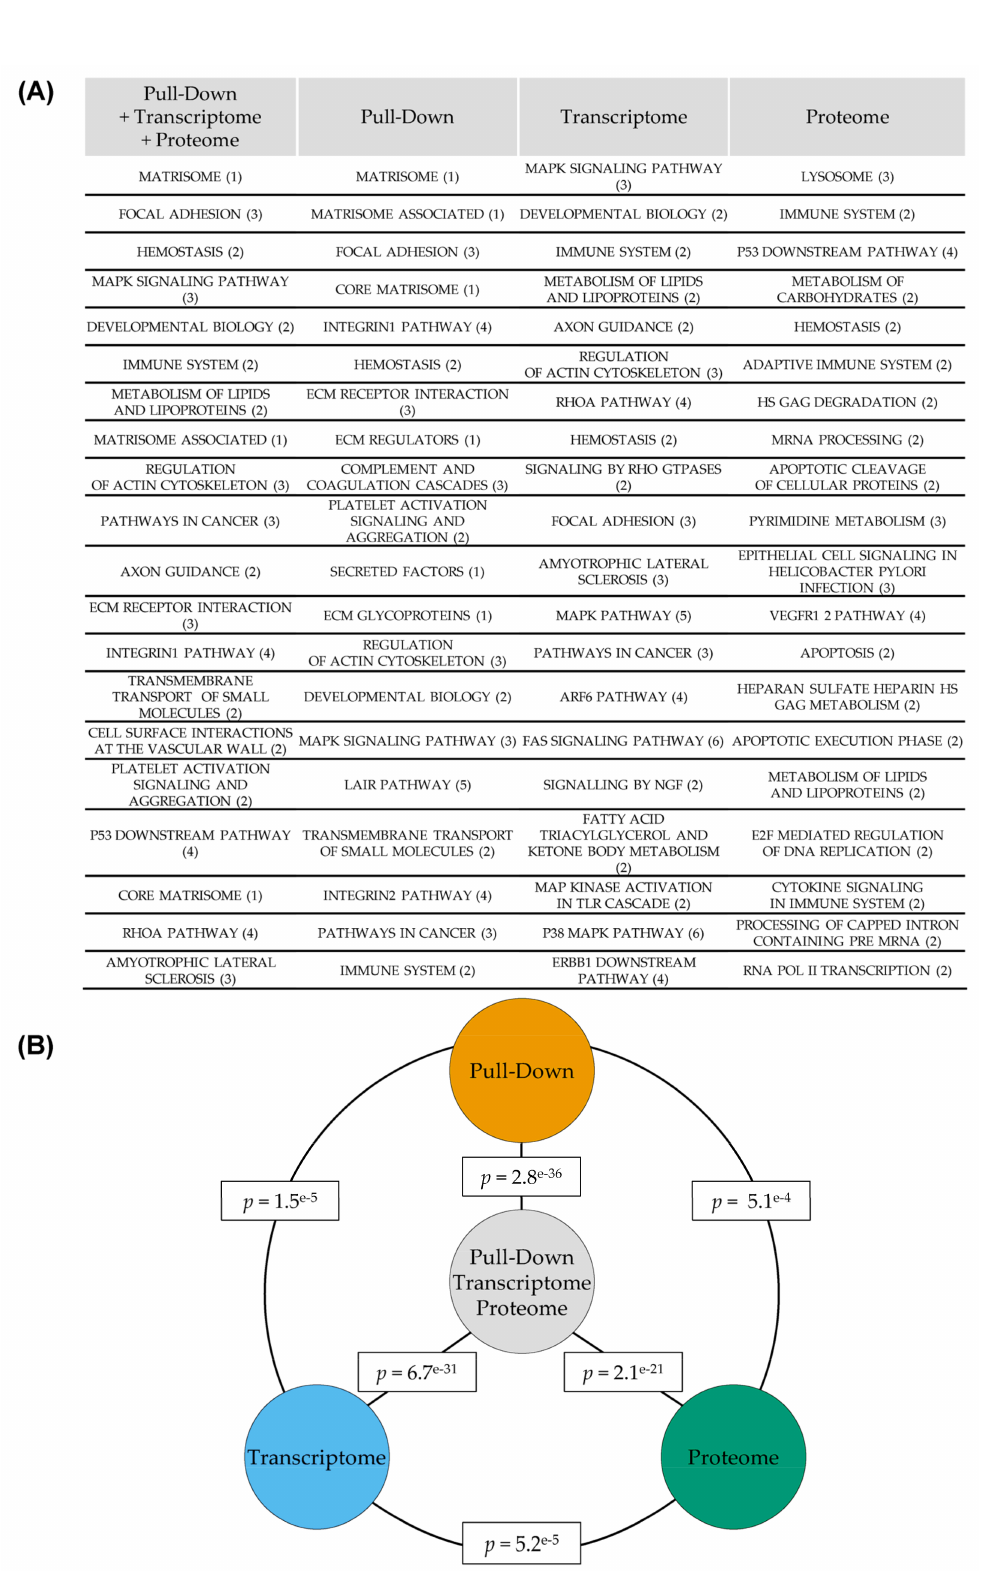
Figure 3. Combination of 3 experiments for pathway analysis provides integrated results. ( A ) Differentially expressed/enriched gene lists from single or combined experiments were analyzed according to several databases. The top 20 most-enriched terms are presented. Number in brackets identifies the database of origin of each term: 1 = NABA, 2 = REACTOME, 3 = KEGG, 4 = PID, 5 = BIOCARTA and 6 = ST. ( B ) Overlaps of the 100 most-enriched terms between individual experiments and between each experiment and the combined analysis were done. The significance of the overlap was calculated with a hypergeometric